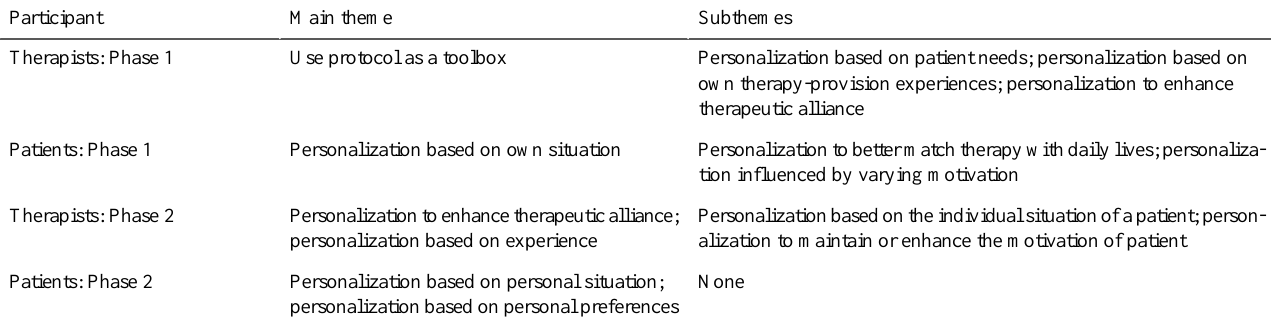
Table 2. Themes and subthemes of the focus group discussions with therapists and patients. SubthemesMain